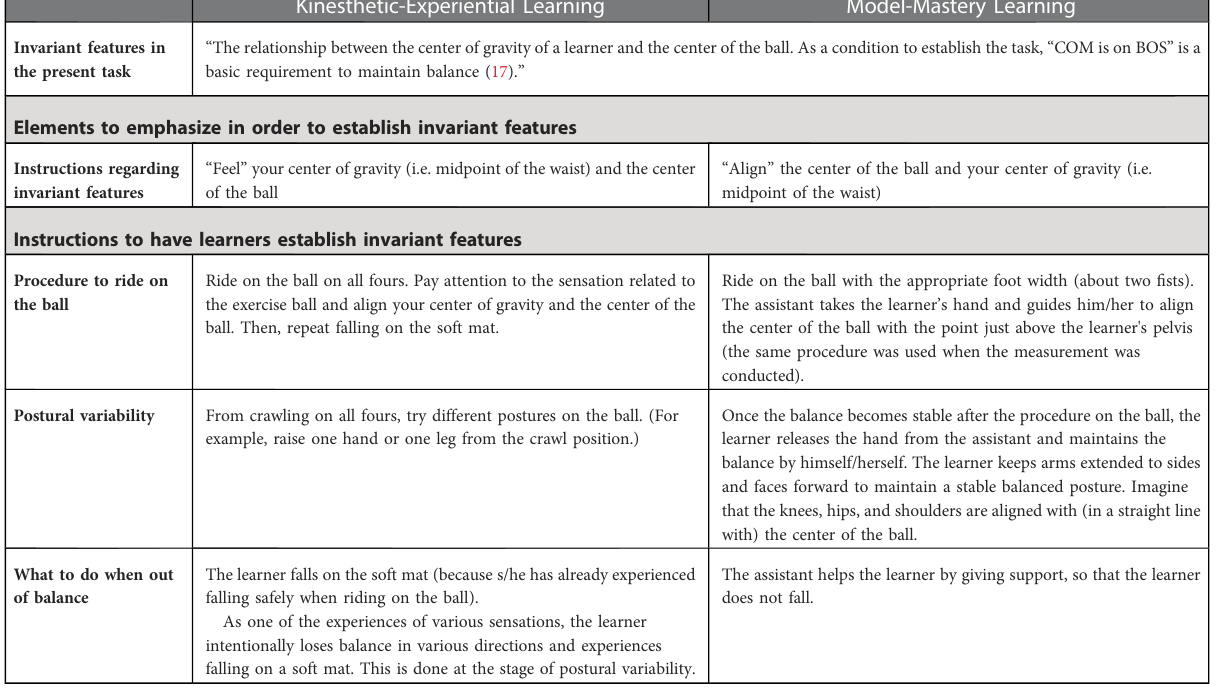
TABLE 2 Speci fi c instructional content of Kinesthetic-Experiential Learning and Model-Mastery Learning methods in the present study. Kinesthetic-Experiential